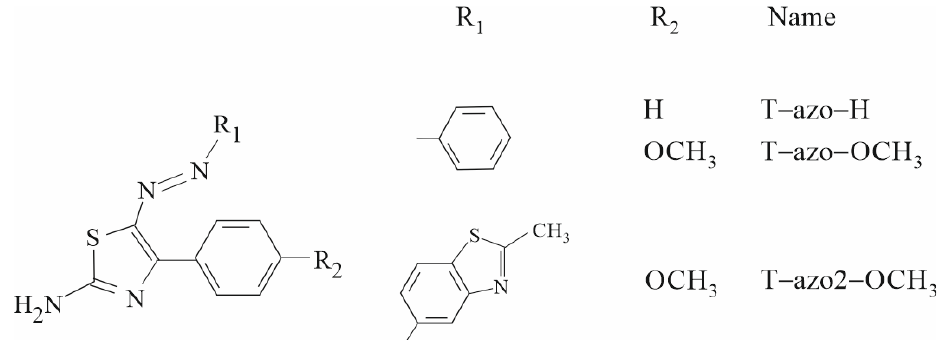
Figure 7. The molecular structures of studied thiazole–azo dyes.